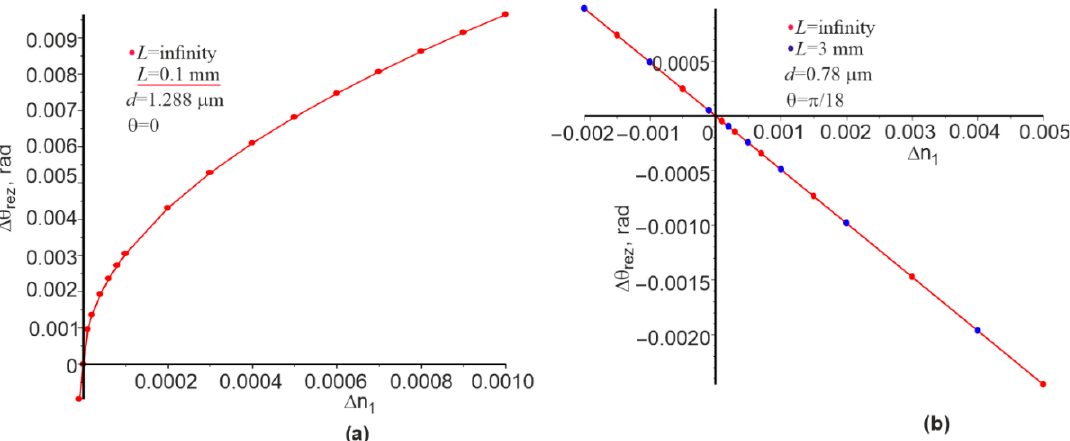
Figure 6. Dependence of ∆ θ rez on the change in refractive index ∆ n 1 for the Gaussian beam and the plane wave at the normal incidence of the Gaussian beam and the plane wave ( a ), and for the Gaussian beam and the plane wave incidence at the angle of π /18 ( b ). A straight red line is drawn between the two extreme points corresponding to the minimum and maximum value of n 1 Table 1. Parameters of the grating (columns 1,2) and beam (column 11), as well as the results of numerical analysis (columns 3–10).